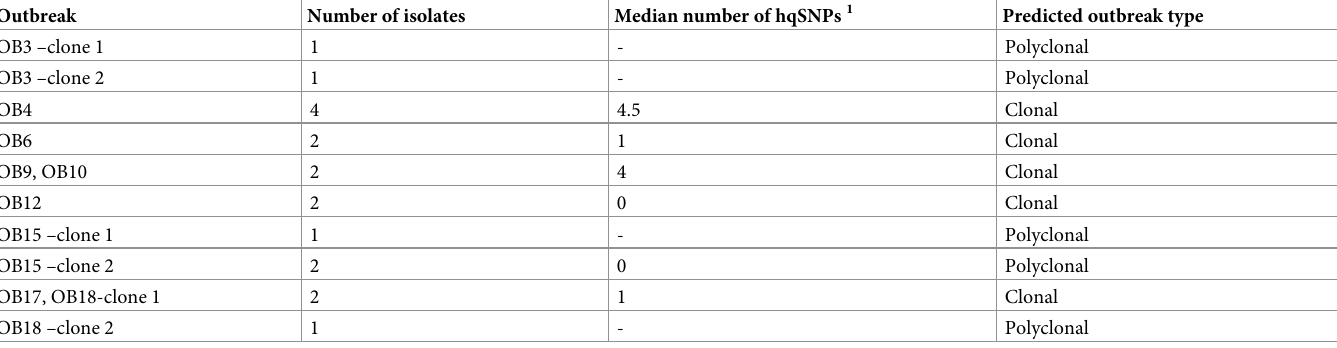
Table 1. Median number of pairwise whole genome high-quality SNPs in ETEC O6 outbreaks are 0–4.5.